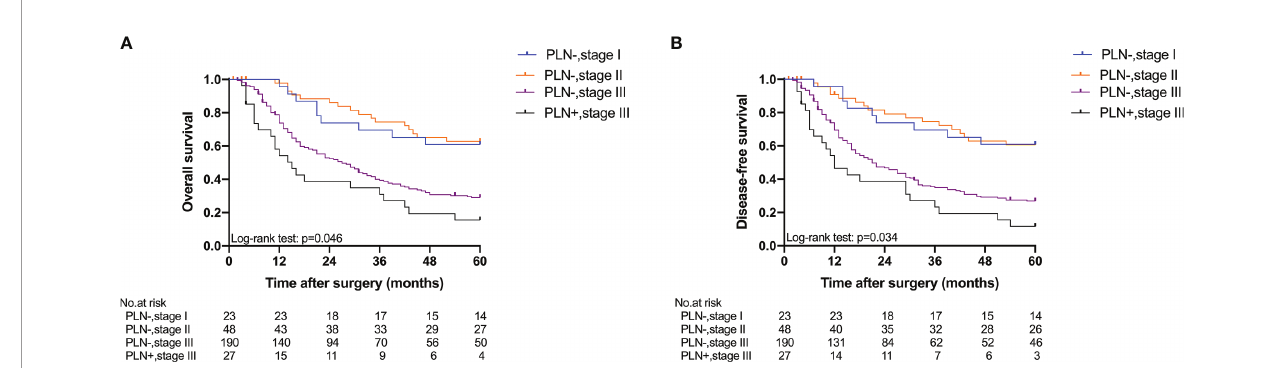
FIGURE 4 | Five-year OS and DFS of all patients classi fi ed by TNM stage and PLN status. (A) OS; (B) DFS (PLN − , stage III vs. PLN+, stage III, p = 0.046 for OS, p = 0.034 for DFS).